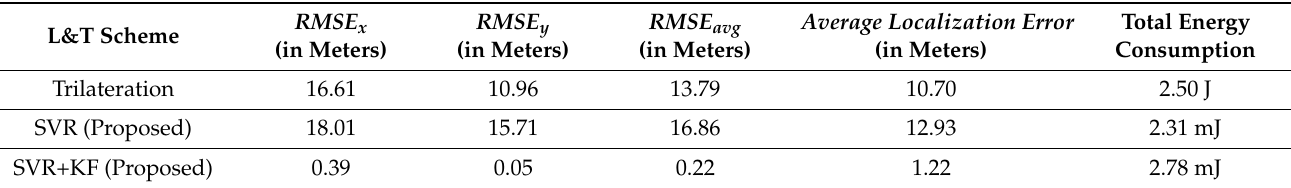
Figure 5. Case II: impact of the sigmoid kernel on SVR-based target localization. ( a ) Location estimates with trilateration, SVR, and SVR+KF against the actual target trajectory, ( b ) localization error with trilateration, SVR, and SVR+KF along the x direction, ( c ) localization error with trilateration, SVR, and SVR+KF along the y direction, ( d ) localization error with trilateration, SVR, and SVR+KF along the x–y direction. Table 5. Average localization error and RMSE for case II.